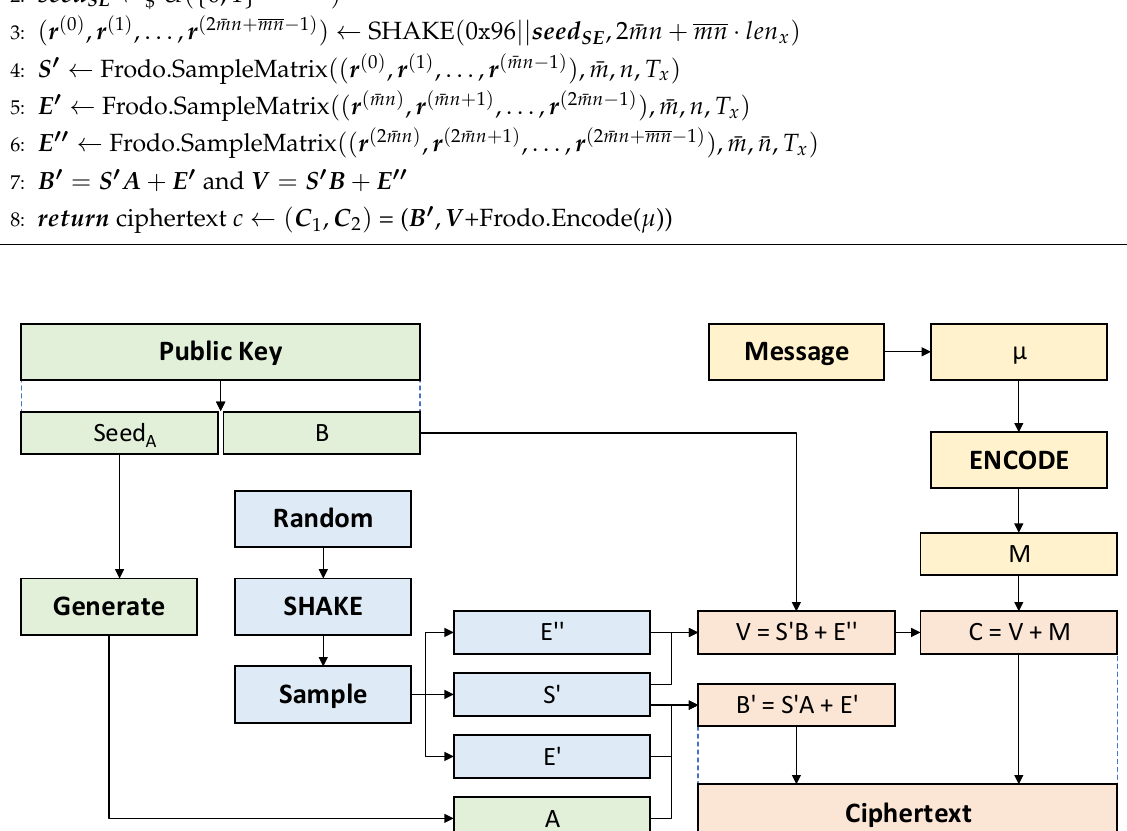
Figure 1. FrodoPKE encryption